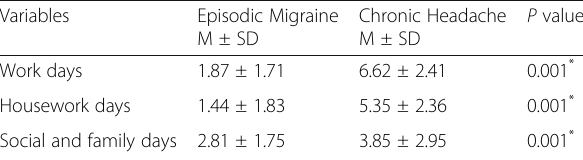
Table 4 Impact of episodic migraine versus chronic headache assessed by HALT questionnaire in preceding 3 months